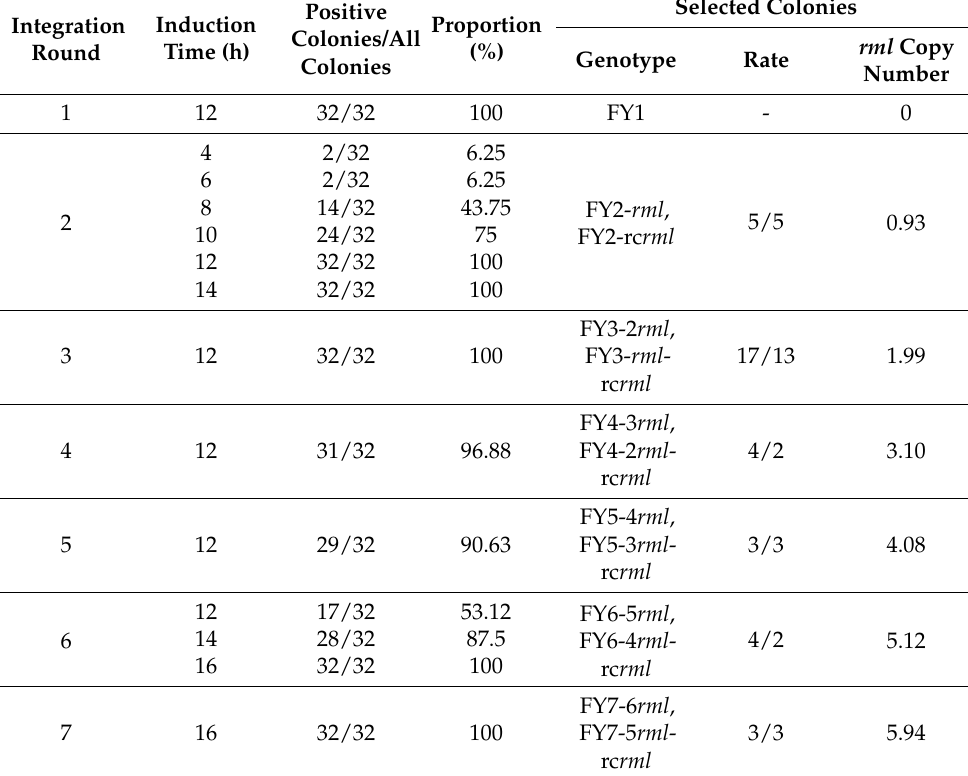
Table 1. Positive colony proportion, genotype rate, and rml copy number determined in this